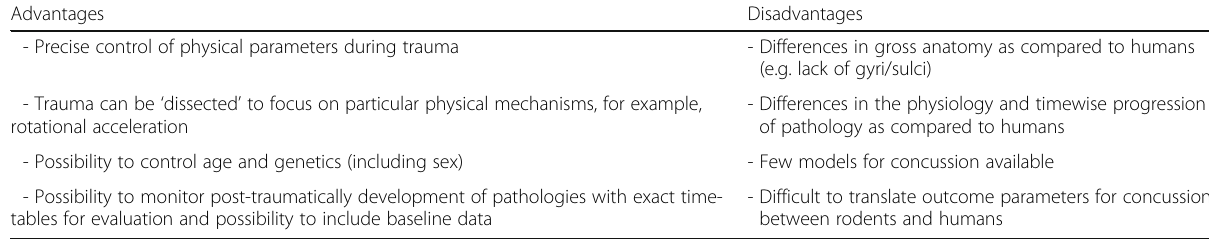
Table 2 Pros and cons of animal